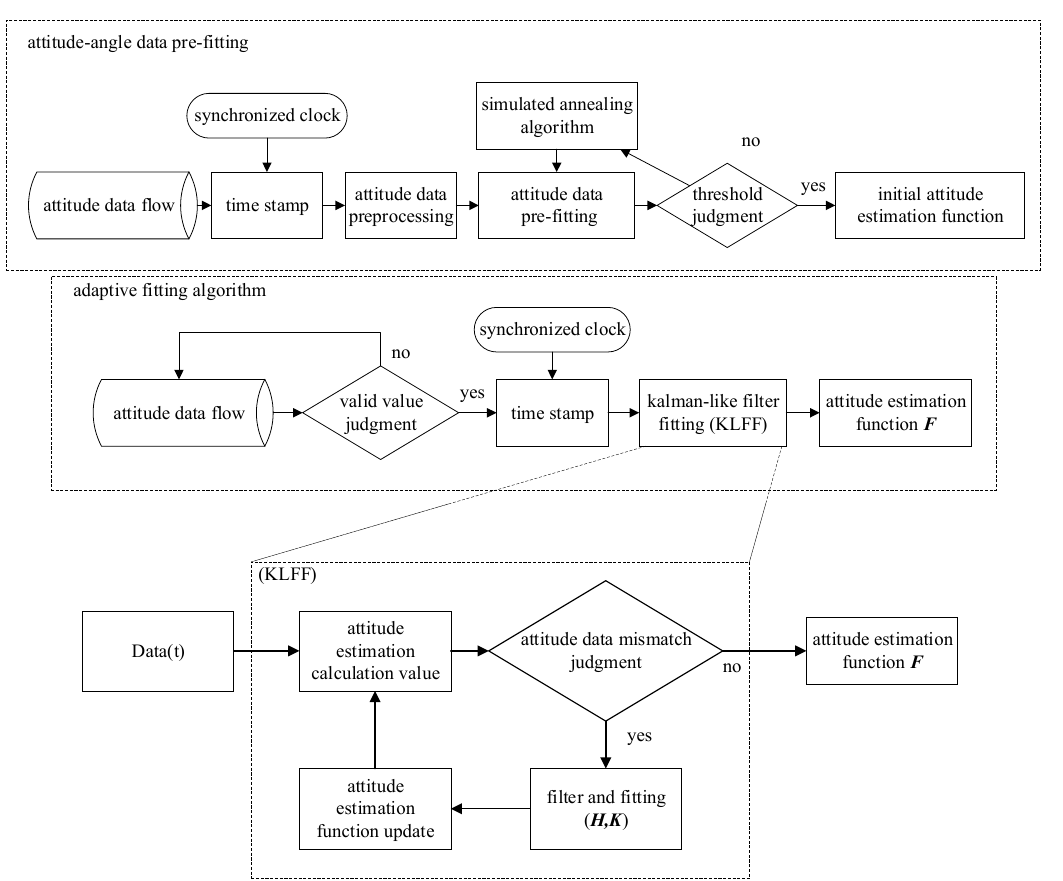
Figure 3. Adaptive attitude function fitting flow chart of Kalman-like filter fitting (KLFF).